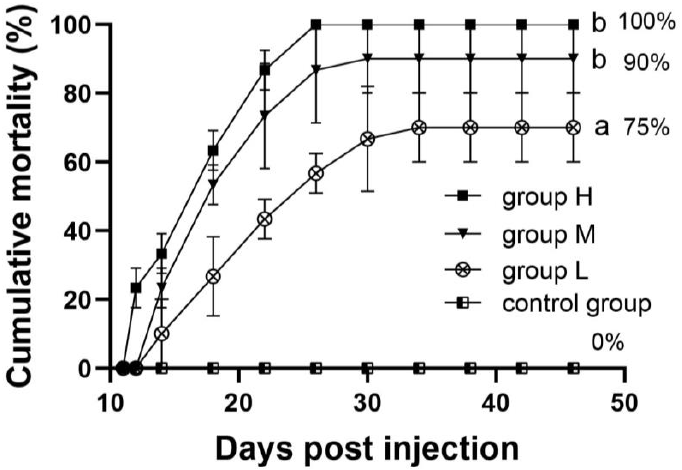
Figure 5. Cumulative percent mortality (%, mean ± SD) in Japanese seabass exposed to M. marinum and mock-injected control fish over a 6-week period. The concentrations of groups L, M, and H were 5 × 10 5 , 5 × 10 6 and 5 × 10 7 CFU/mL, respectively. Significant differences (p < 0.05) are marked by different letters.